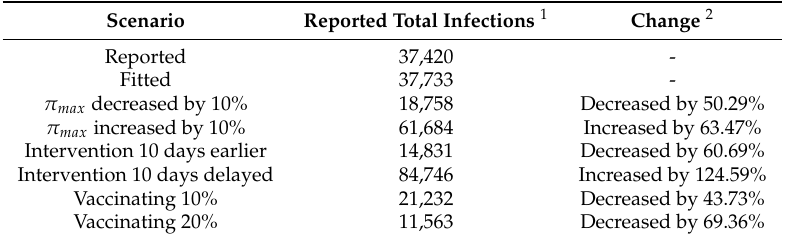
Table 4. The total number of infections reported and simulated in assumed